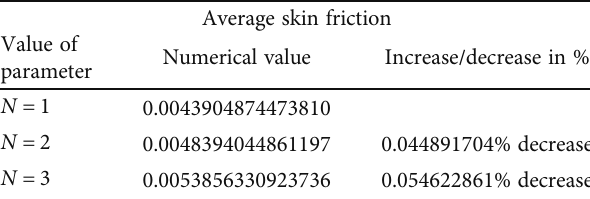
Table 11: Variability of the curve when Y = 1 in Figure